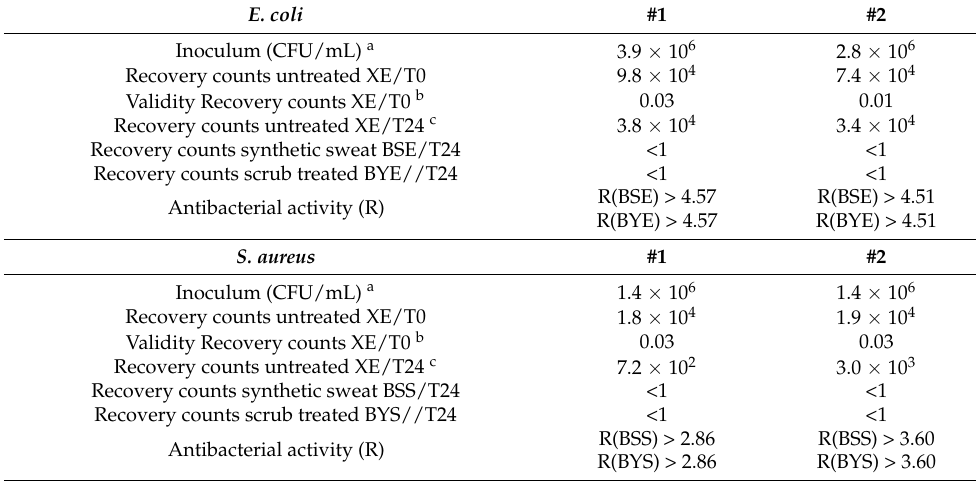
Table 4. Antibacterial activity of Ag 0.01 M-treated surfaces against E. coli and S. aureus after exposure to synthetic sweat and